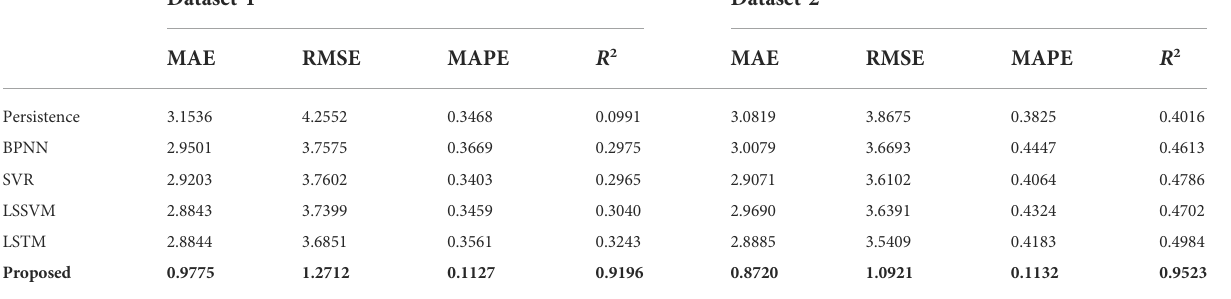
TABLE 5 Performance metrics of six models on experiment Ⅰ